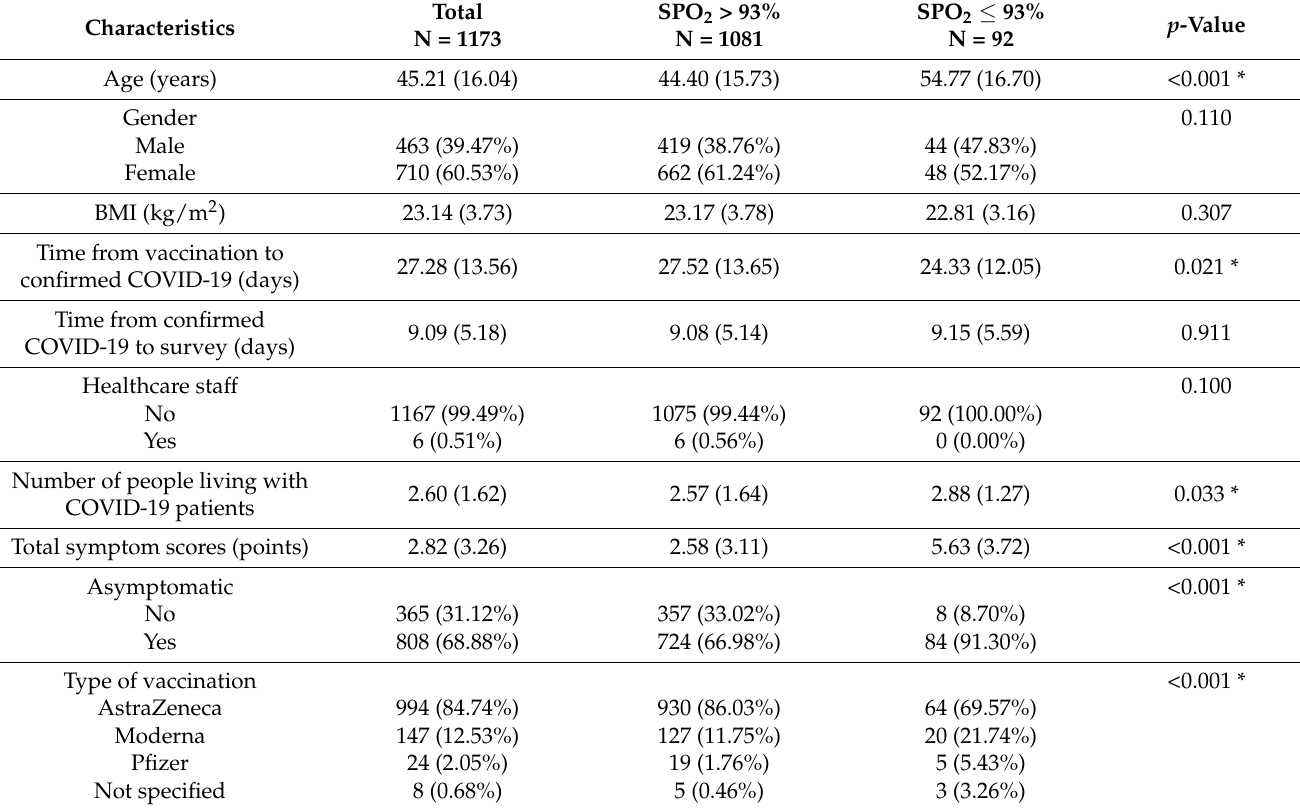
Table 2. Baseline characteristics of the included patients according to the SPO 2